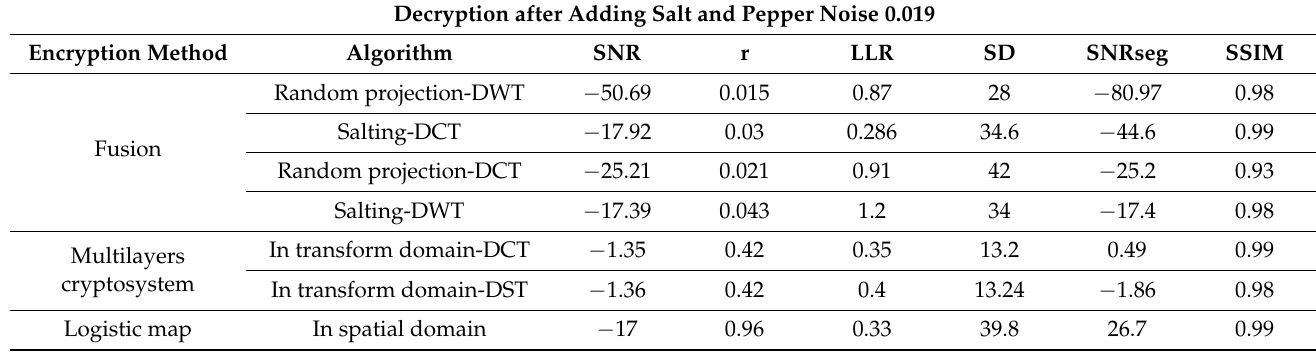
Table 4. Comparison of different decrypted signals after applying salt and pepper noise. Decryption after Adding Salt and Pepper Noise 0.019